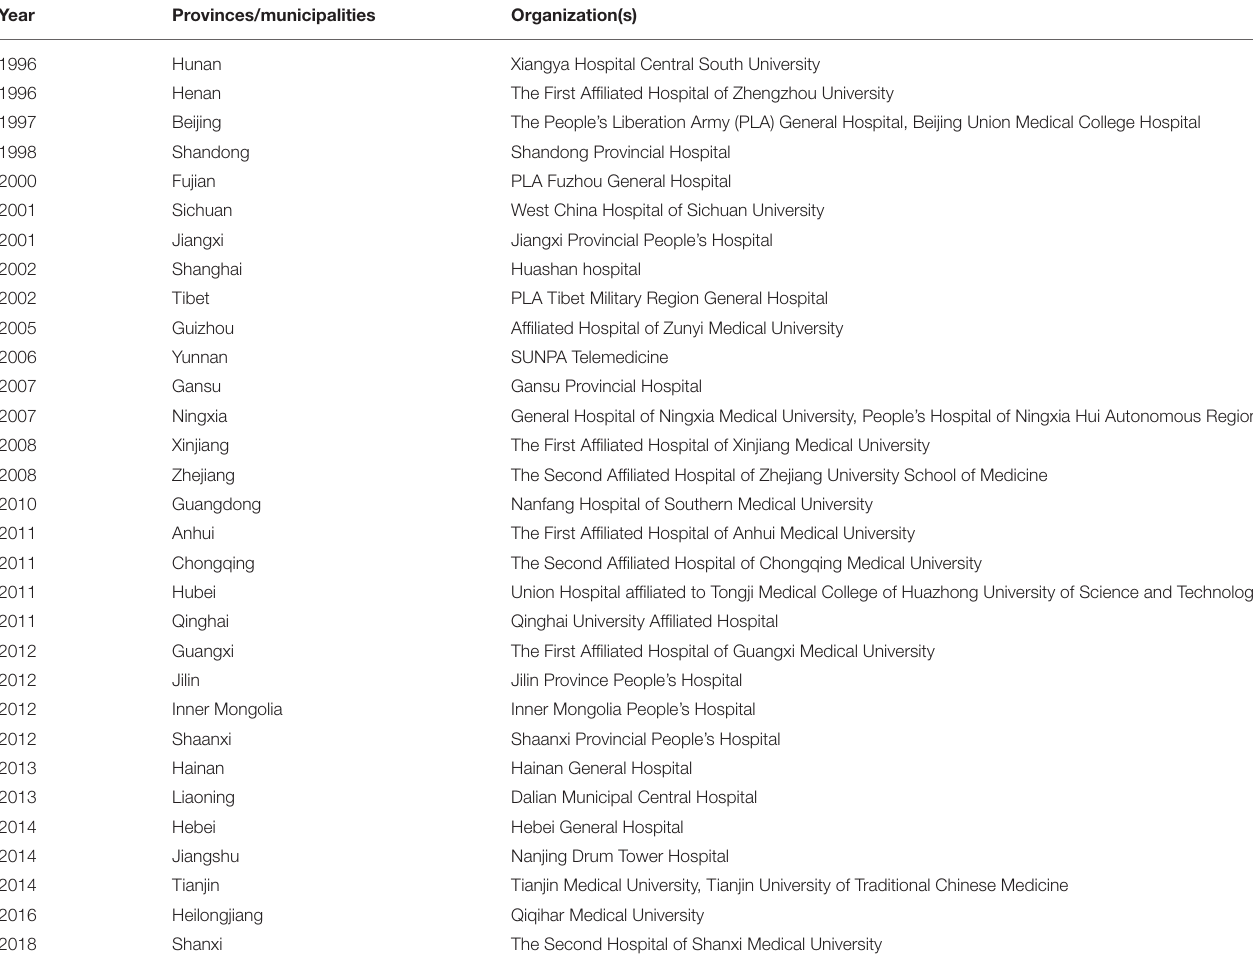
TABLE 2 | The time and organization that firstly initiated telemedicine network/center in the 31 provinces and municipalities in mainland of